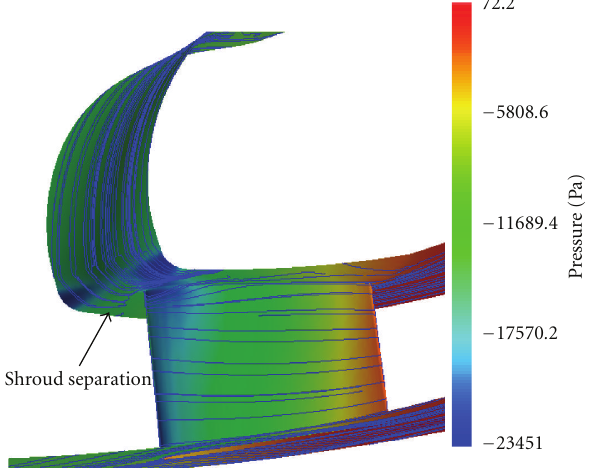
Figure 8: Flow traces near B#2 impeller